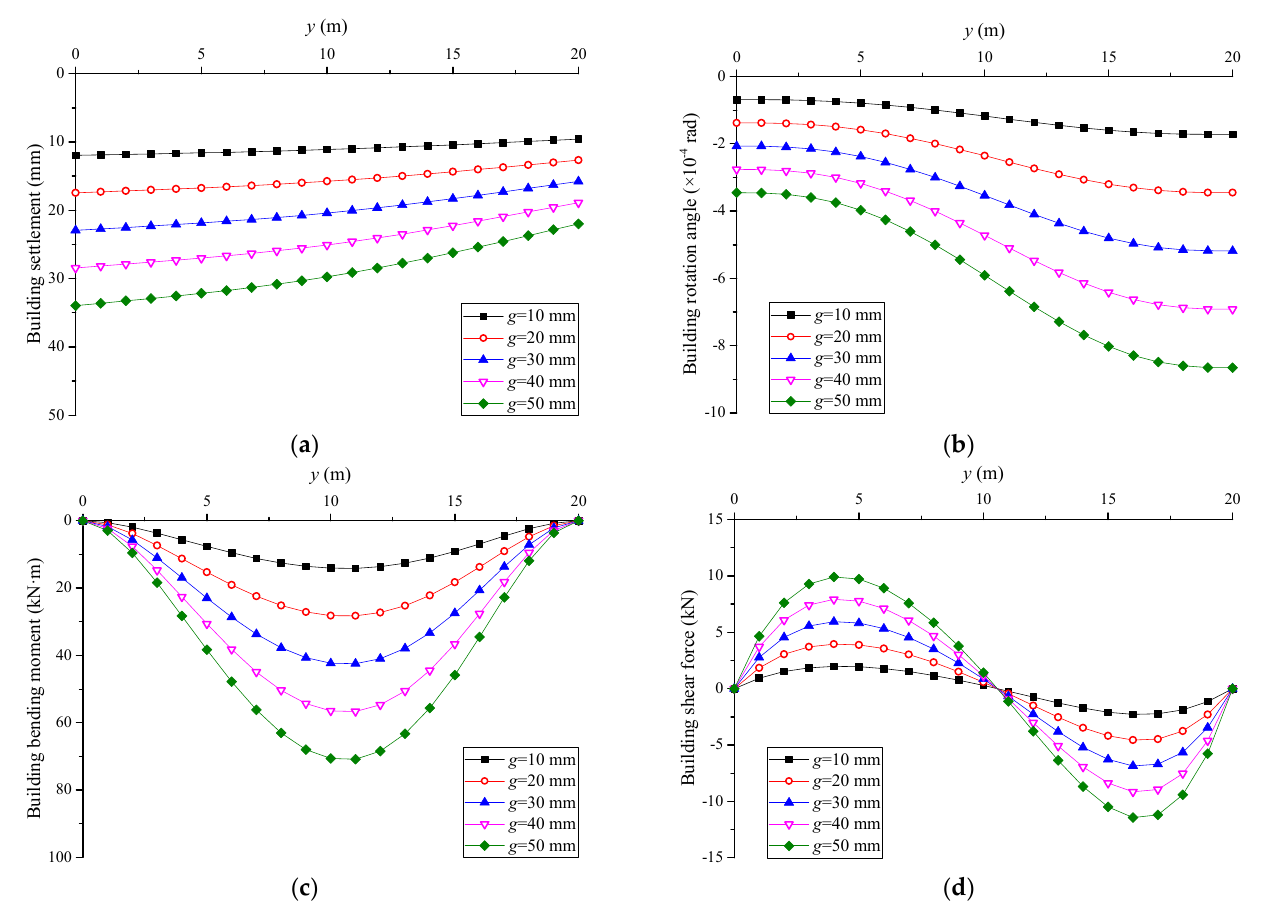
Figure 14. Building response with different gap parameters: ( a ) settlement; ( b ) rotation angle; ( c ) bending moment; ( d ) shear force.